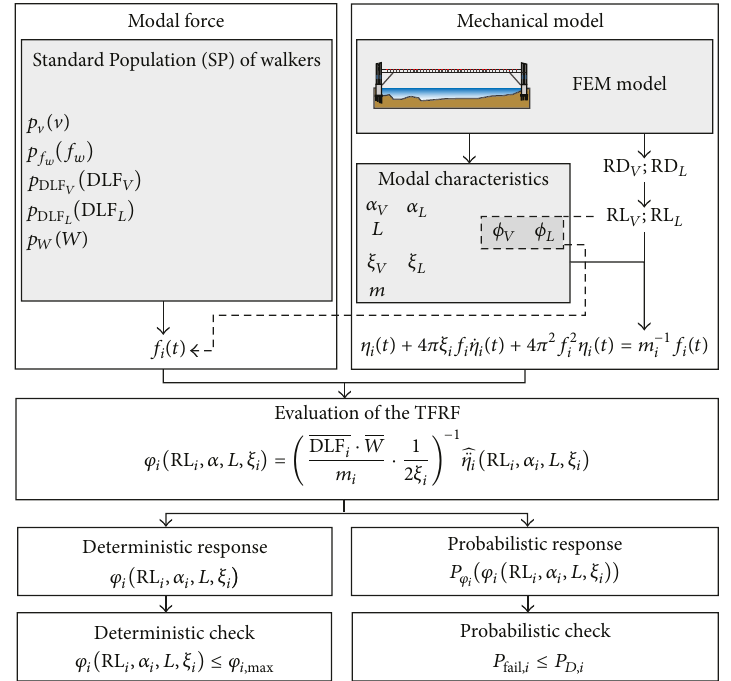
Figure 4: Deterministic and probabilistic assessment